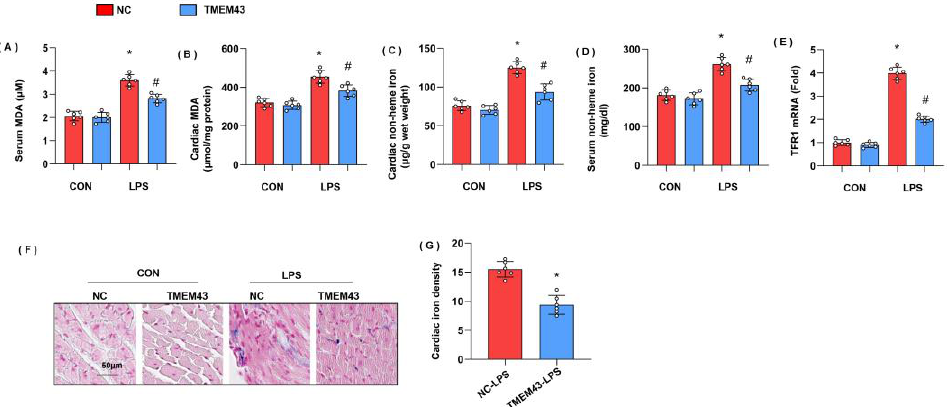
Figure 6. TMEM43 overexpression alleviates LPS-induced ferroptosis. ( A , B ) Serum and cardiac MDA level in mice injected with AAV-TMEM43 under LPS challenge ( n = 6). ( C , D ) Serum and cardiac non-heme iron in mice injected with AAV-TMEM43 under LPS challenge ( n = 6). ( E ) mRNA level of TFR1 in mouse hearts ( n = 6). ( F , G ) Prussian blue staining and quantified results in mice injected with AAV-TMEM43 under LPS challenge ( n = 6). * p < 0.05 vs. AAV-NC/CON group. # p < 0.05 vs. AAV-NC/LPS group.